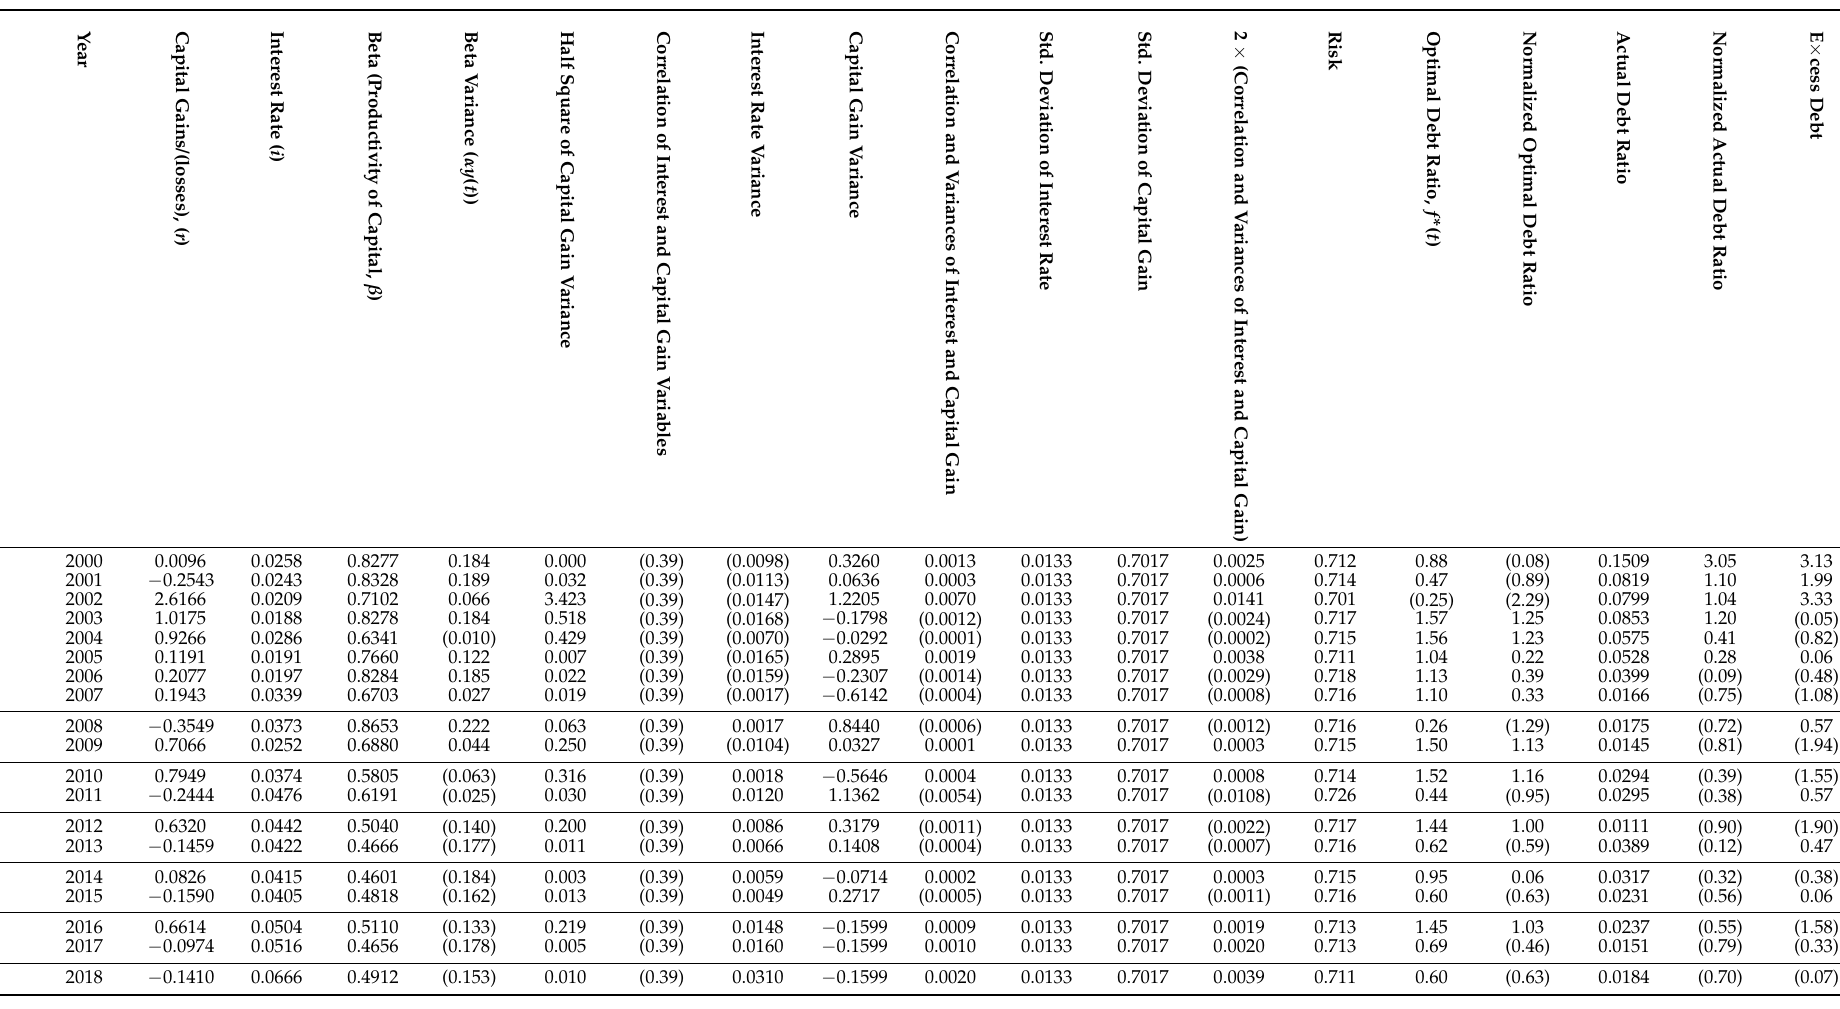
Table A10. Calculations of Optimal and Excess Debt: Bank OCBC